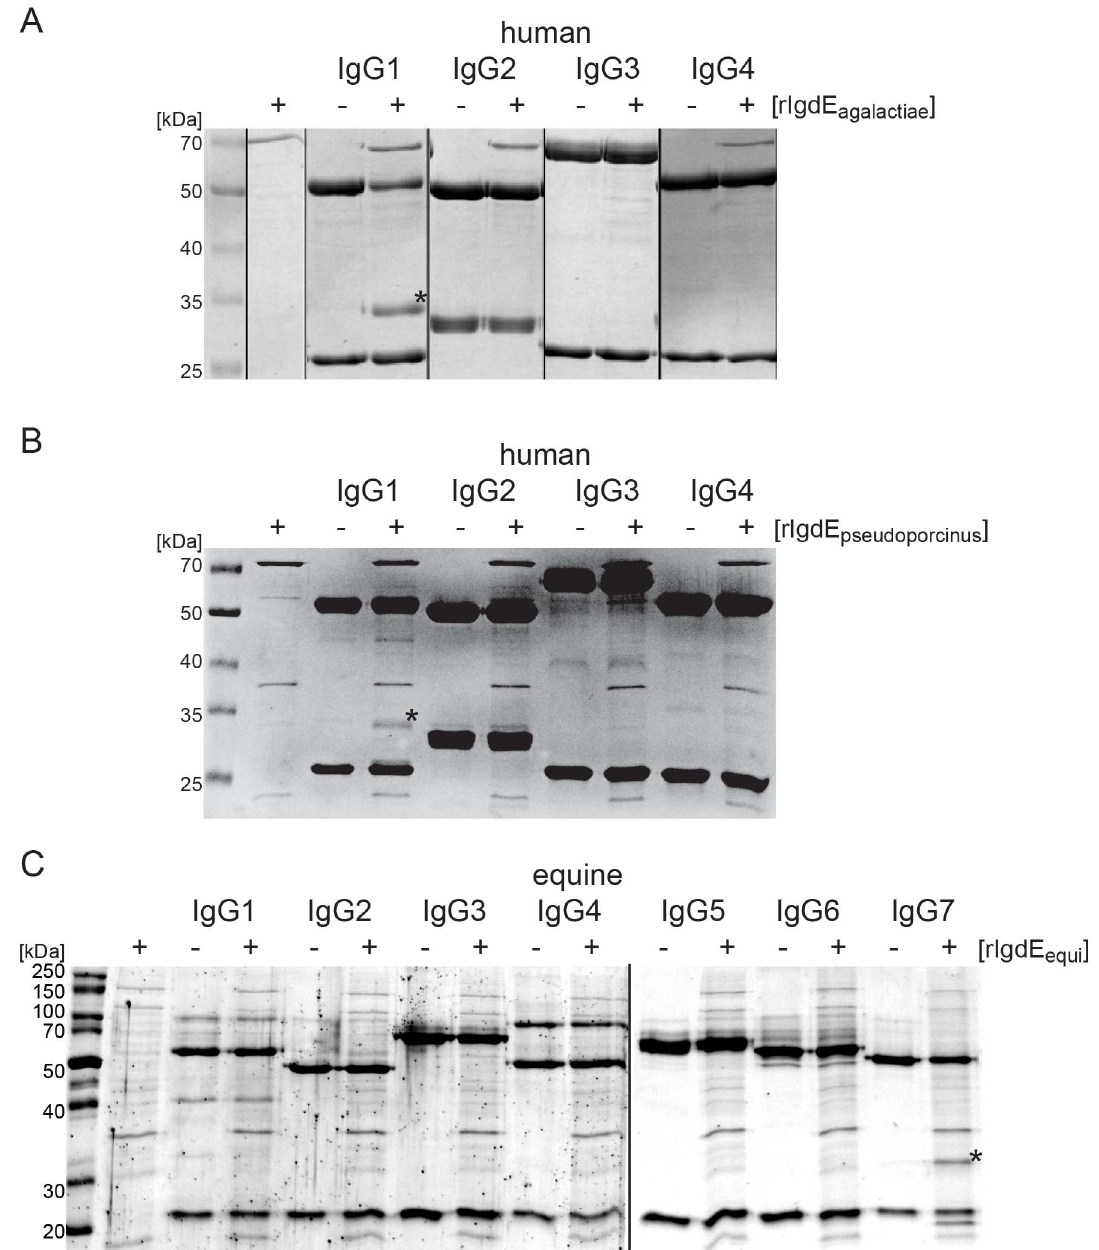
Fig 5. IgdE agalactiae , IgdE pseudoporcinus and IgdE equi are IgG subtype specific. (A) 0.25 mg/ml human IgG subtypes were incubatedfor 16h at 37˚C with (+) or without (-) 20 μ g/ml purified rIgdE agalactiae . Reactions were analyzedby SDS-PAGE under reducing conditions. IgG cleavage( * ) occurred only upon incubationwith IgG1. SDS-PAGE was stained with Coomassieblue. Order of lanes within SDS-PAGE was adjusted.(B) 0.25 mg/ml human IgG subtypes were incubated for 16h at 37˚C with (+) or without (-) 5% soluble fraction of E . coli cells expressing rIgdE pseudoporcinus . Reactions were analyzed by SDS-PAGE under reducing conditions. IgG cleavage( * ) occurred only upon incubationwith IgG1. SDS-PAGE was stained with Coomassie blue. (C) 0.09 mg/ml recombinantequineIgG subtypes were incubatedfor 16h at 37˚C with (+) or without (-) 5% soluble fraction of E. coli cells expressing rIgdE equi . Reactions were analyzedby SDS-PAGE under reducing conditions. IgG cleavage( * ) occurred only upon incubationwith IgG7. SDS-PAGE was stained with Coomassie Fluor Orange Protein Gel Stain. Images of different SDS-PAGE run in parallelhave been assembled into one